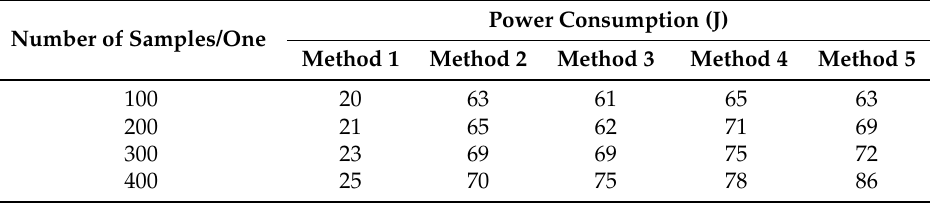
Table 1. Comparison of different methods of network node control power